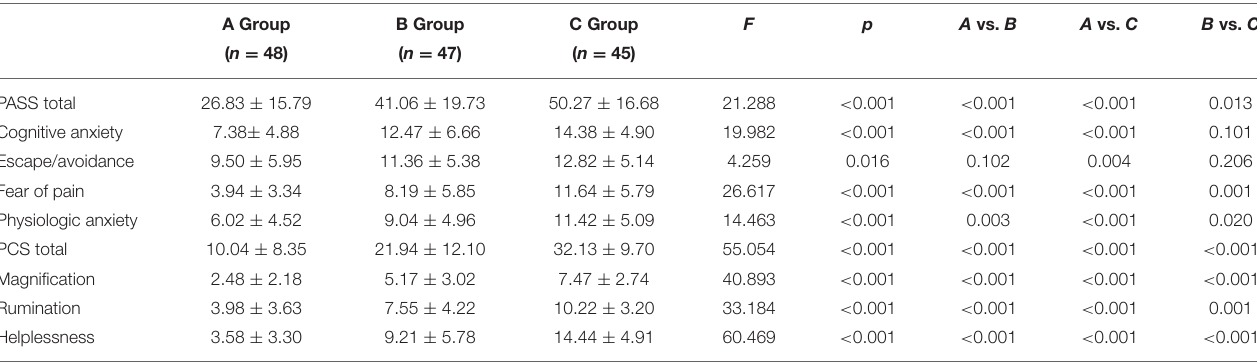
TABLE 2 | Pain-related anxiety and pain catastrophizing properties among three groups.